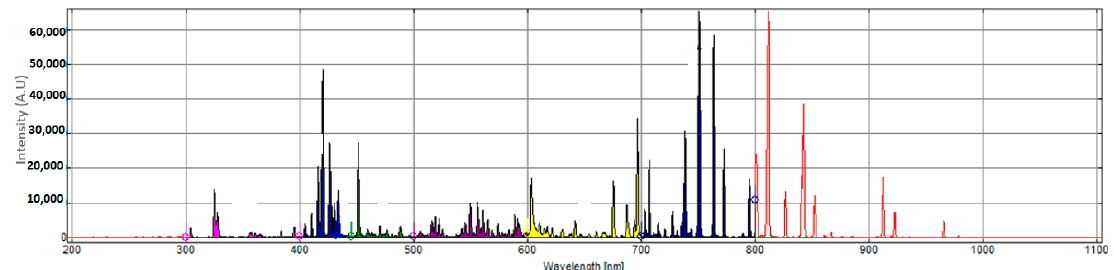
Figure 11. The emission spectra of the plasma were segmented into seven sections: a, b, c, d, e, f and UV. Where the UV covered emissions from 300–400 nm. a: 400–430, b: 431–449, c: 450–500, d: 500–600, e: 600–700, and f: 700–800 nm. The area under each region was calculated and monitored.